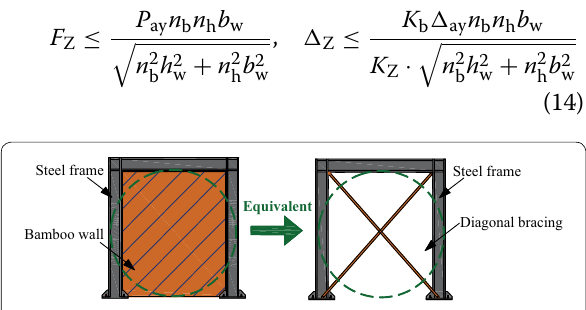
Fig. 13 Equivalent diagonal bracing of bamboo infilled